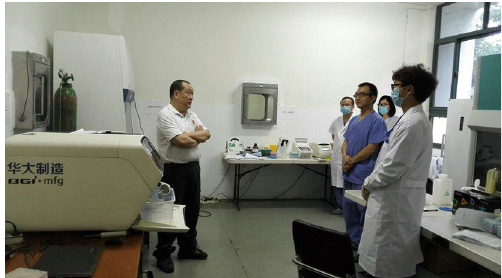
Figure 3. Ebola virus genomes were assembled and ana- lyzed by the Chinese deep sequencing platform in Free- town. The lead of the second team, Professor Yuelong Shu was discussing the sequencing project with the colleagues.